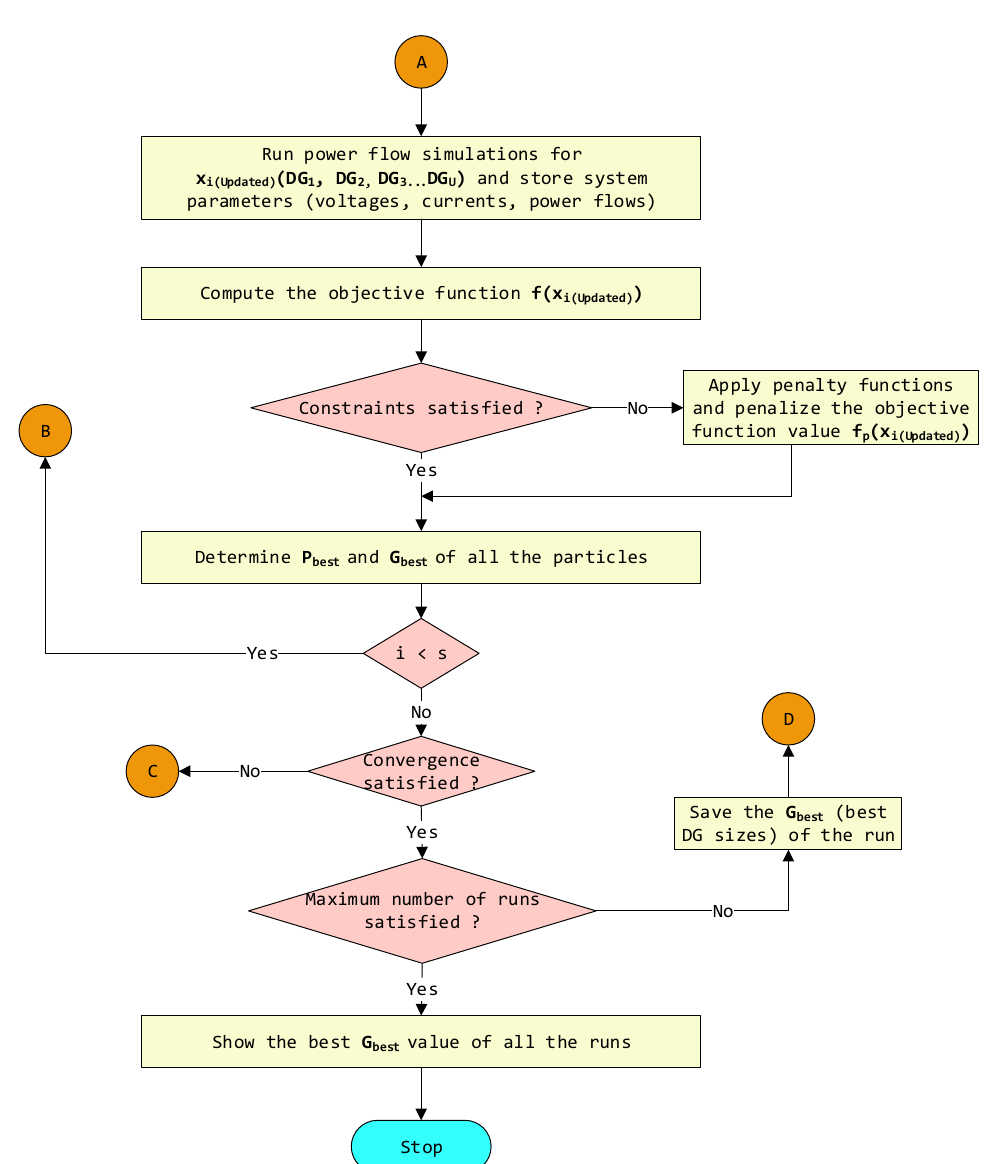
Figure 5. Flow chart of optimal sizing of DGs utilizing the particle swarm optimization (PSO) algorithm—Algorithm